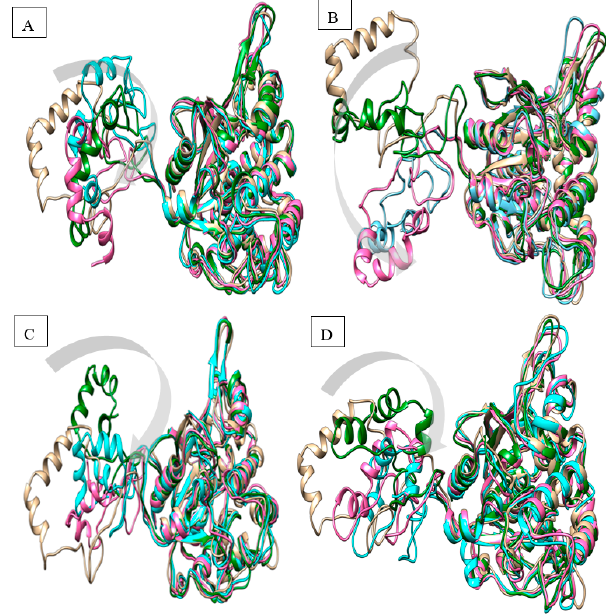
Figure 3. Superimposition of the simulated native lipase at different time intervals. ( A ): 10 °C; ( B ): 20 °C; ( C ): 30 °C; ( D ): 40 °C. Native: brown (0 ns); Green: 10 ns; Pink: 15 ns; Cyan: 20 ns. Movement of the N-terminal domain is indicated by a grey arrow. Table 1. Summary of N-terminal movement.